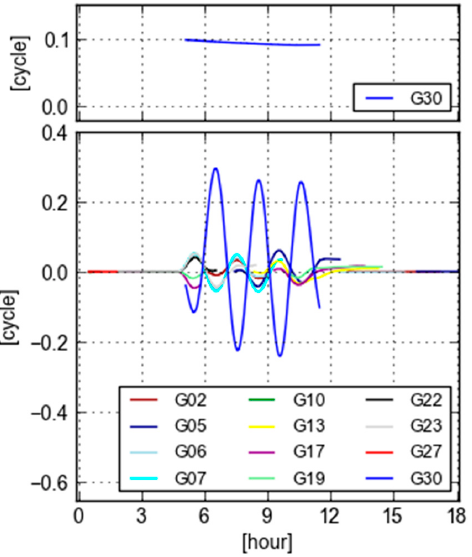
Figure 10. Recomputed GB-GF WL ambiguities minus the previous ones in Figure 5 with the simulated constant bias ( top ) and the time-variant errors ( bottom ) added into orbit clock of PRN 30 at Site